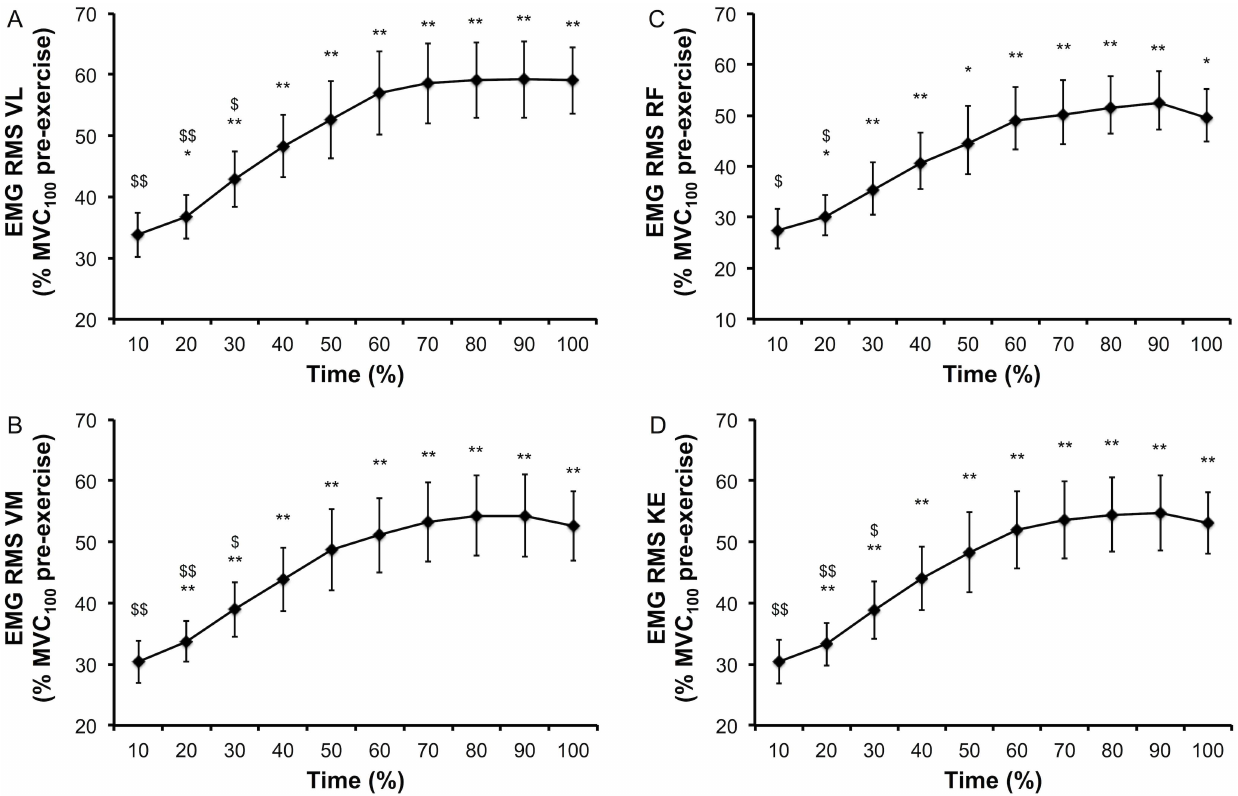
Fig 5. Time course of EMG root mean square (EMG RMS) normalized by the maximum EMG RMS pre-exercise at 100 deg/s (MVC 100 ) during the time to exhaustion tests (85% peak power output). EMG RMS was measured for the followingmuscles: Vastus Lateralis (VL), Rectus Femoris (RF), Vastus Medialis (VM) and the overall knee extensors (KE; sum of VL, RF and VM). Data are presented as main effect of time and mean (SE). * significantly different from 10% and $ significantly different from 100%, 1 item for P < 0.05, 2 items for P < 0.01 and 3 items for P <